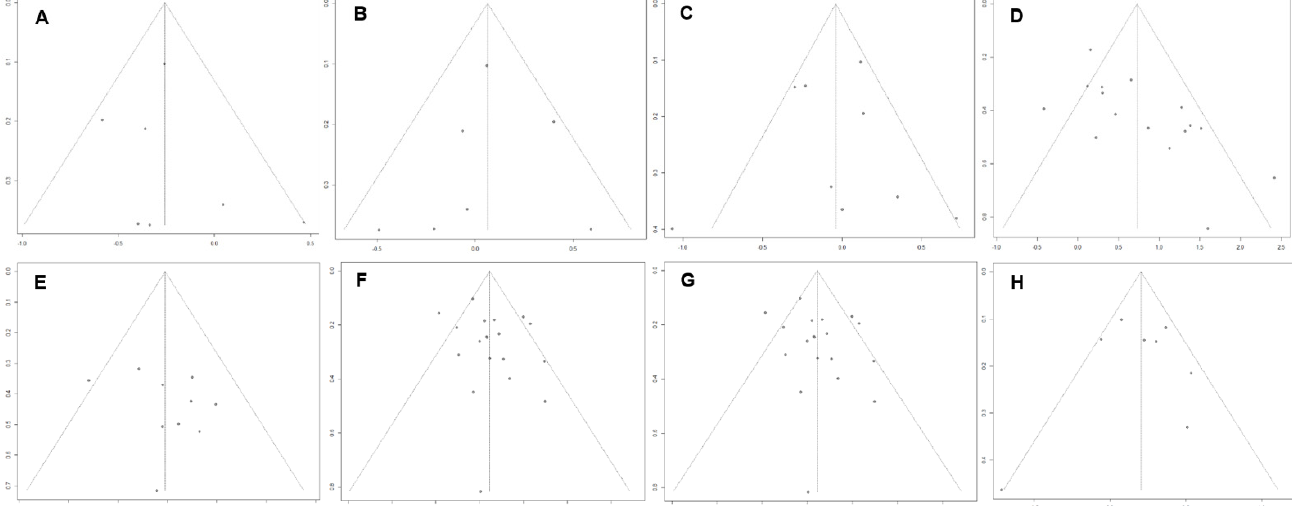
Figure 3. Funnel plots of x axis: standardised mean difference, y axis: standard error, for studies included in meta-analysis to visually assess publication bias. Panel ( A ) Systolic blood pressure. Panel ( B ) Diastolic blood pressure. Panel ( C ) Body mass index. Panel ( D ) Objective sleep duration. Panel ( E ) Objective sleep efficiency. Panel ( F ) Subjective sleep duration. Panel ( G ) Subjective sleep quality. Panel ( H ) Perceived health